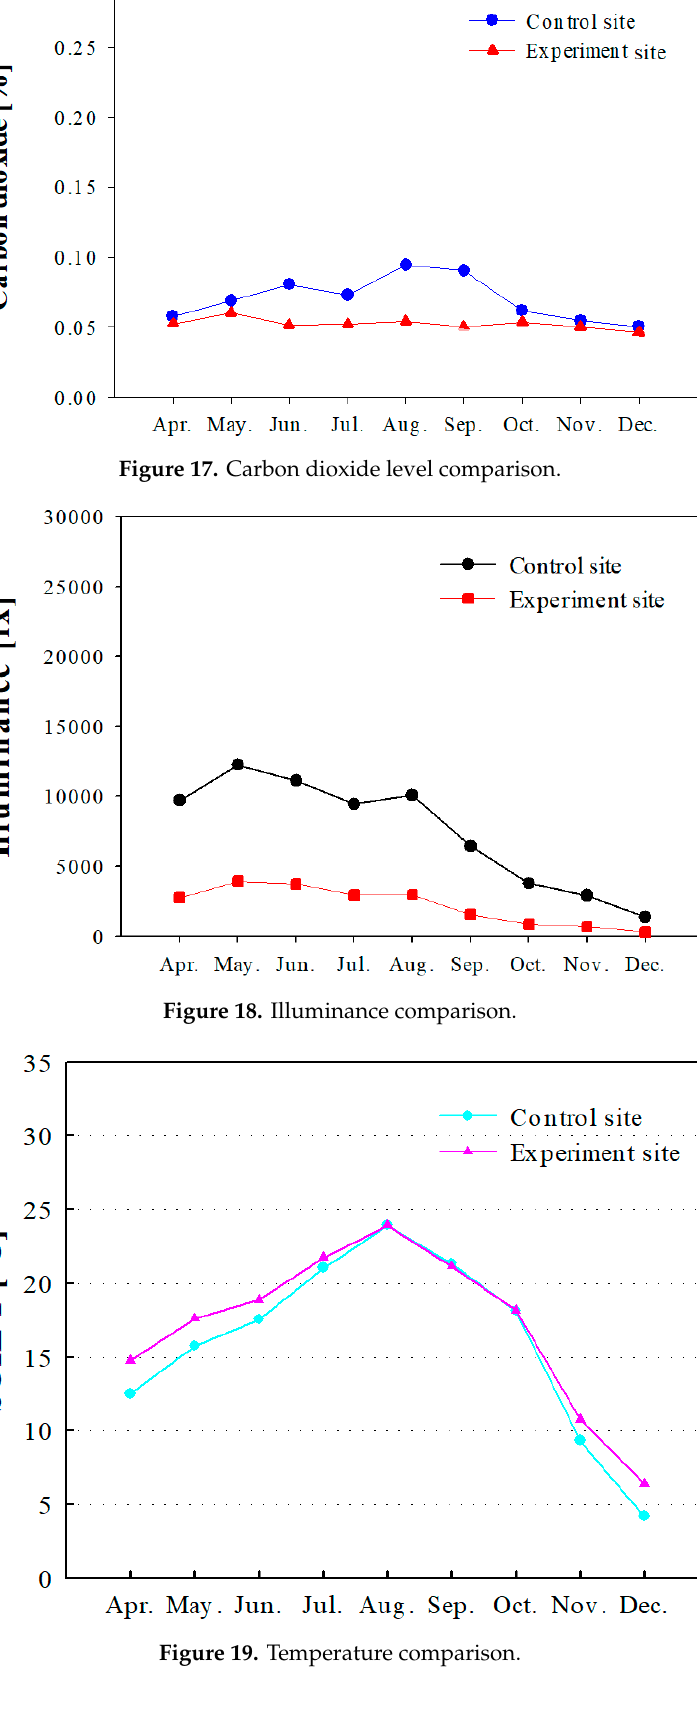
Figure 17. Carbon dioxide level comparison.